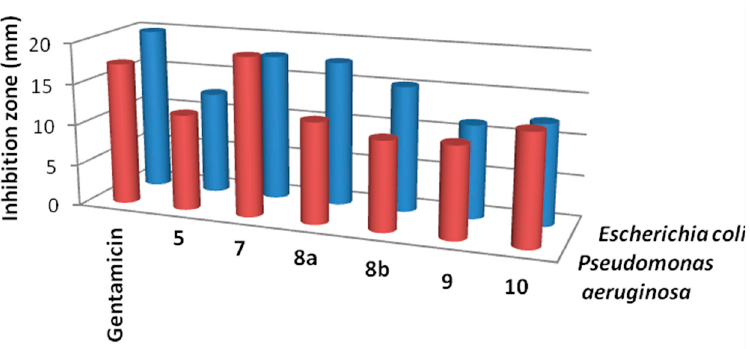
Figure 3. Activity of the synthesized thiophene derivatives against Gram negative bacteria.